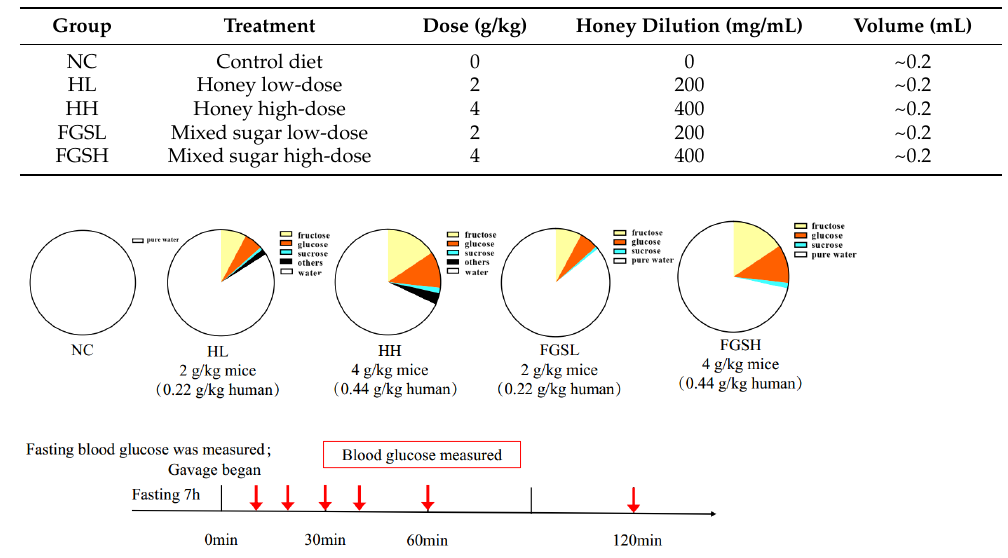
Figure A1. Single-dose timeline of events and experimental design used.